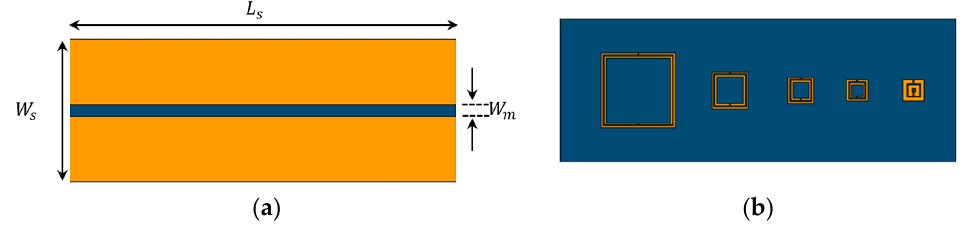
Figure 2. Microwave sensor array with ( a ) front surface and ( b ) back surface.